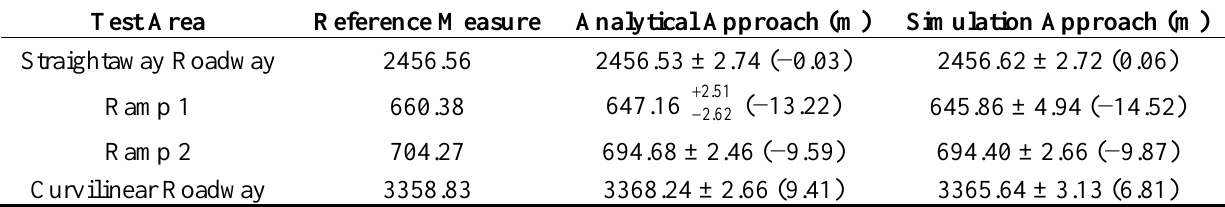
Table 2. Uncertainties in route measures * .